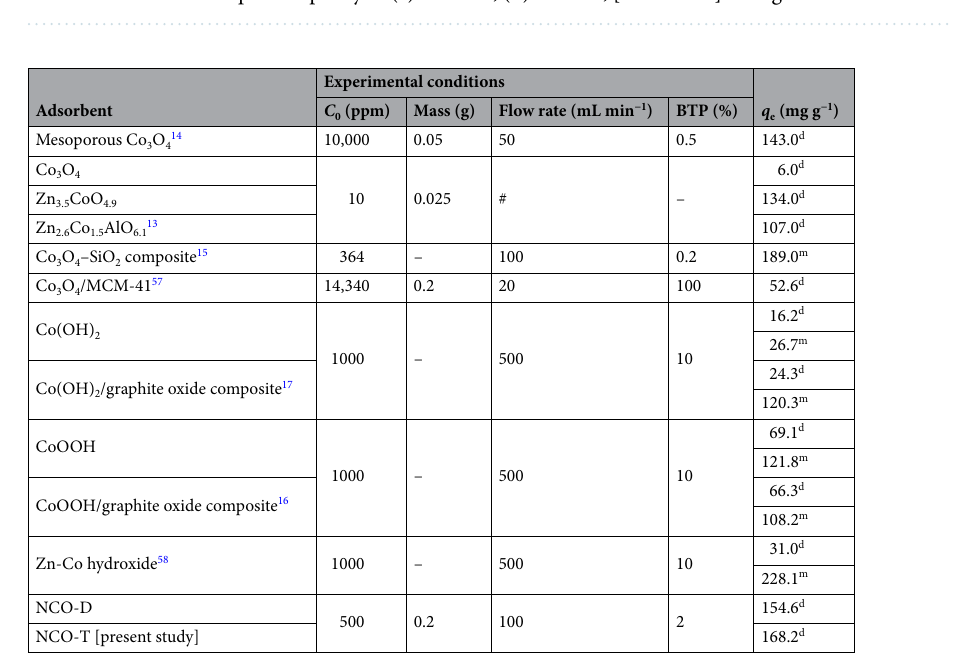
Figure 5. Effect of dosage on the adsorption capacity of ( a ) NCO-D; ( b ) NCO-T, flowrate = 0.1 L min −1 ; effect of flowrate on the adsorption capacity of ( c ) NCO-D; ( d ) NCO-T, [Adsorbent] = 0.2 g.